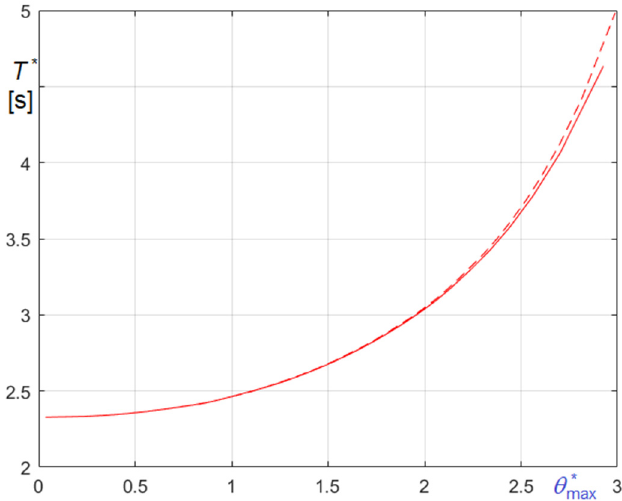
Figure 26. Comparison of the apparent period, T ∗ , maximum amplitude, θ ∗ max , curves of undamped (solid line) and damped (dashed line) forced oscillations.